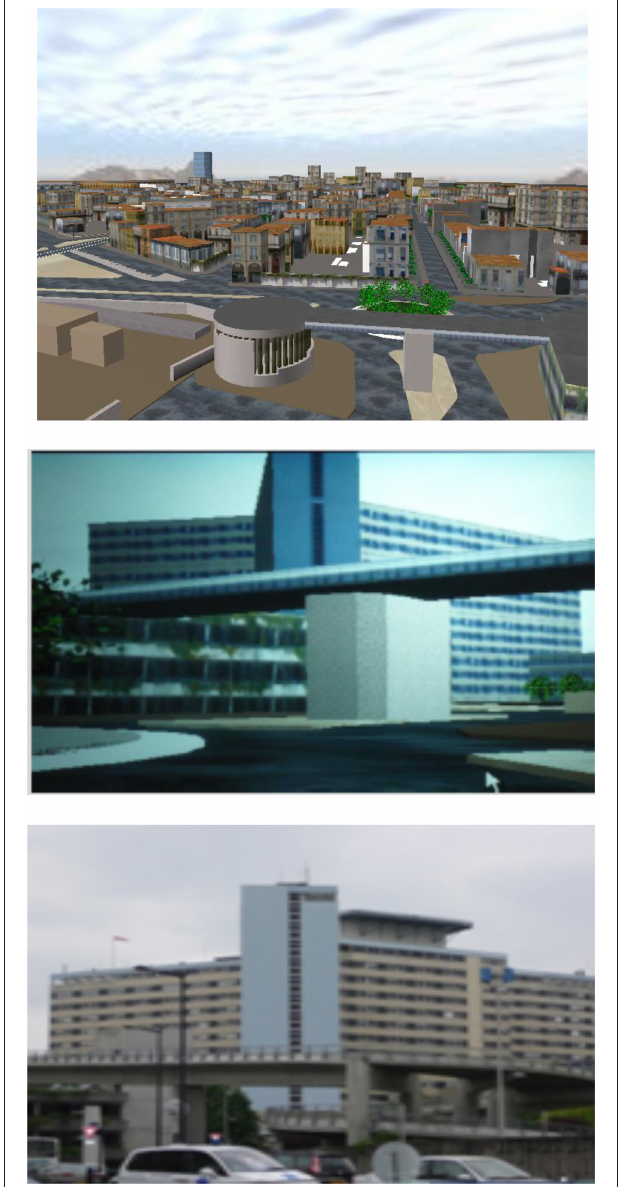
FIGURE 1 | Aerial and egocentric views from Virtual Environment (Top, adapted from Taillade et al., 2014) and Egocentric view of Real Environment (Bottom) used for navigational task.